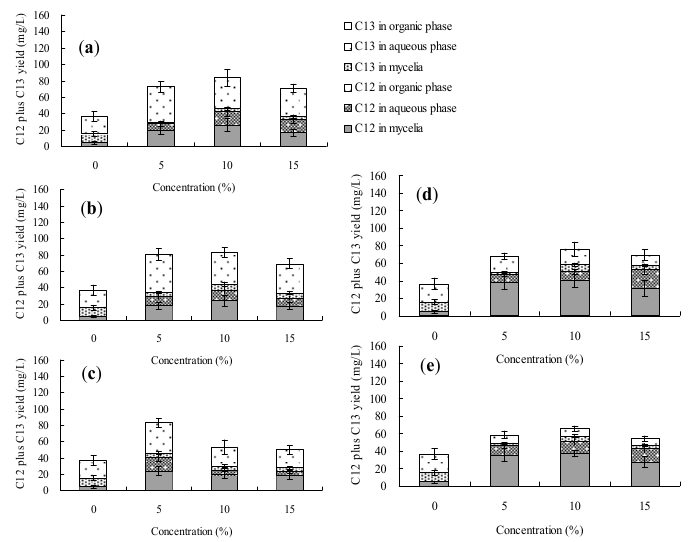
Figure 7. Effects of n -hexadecane on palmarumycin production in liquid culture of Berkleasmium sp. Dzf12. n -Hexadecane was applied at 0%, 5%, 10% and 15% on days 0 ( a ); 3 ( b ); 6 ( c ); 9 ( d ) and 12 ( e ) of culture, respectively. The period of culture lasted for 15 days. “C12” means palmarumycin C 12 , “C13” means palmarumycin C 13 . The error bars represent standard deviations from three independent samples.